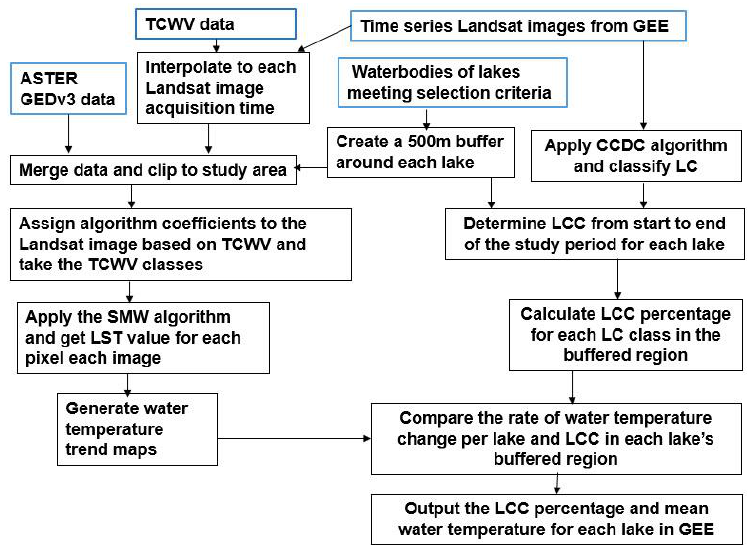
Figure 3. Overview of method workflow used in this